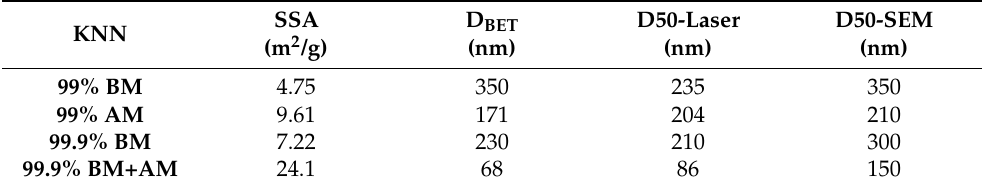
Table 2. KNN powders’ physical characteristics. Specific surface area (SSA) and respective equivalent particle diameter (D BET ), and mean particle size from laser diffraction (D50-laser) and SEM images (D50-SEM).